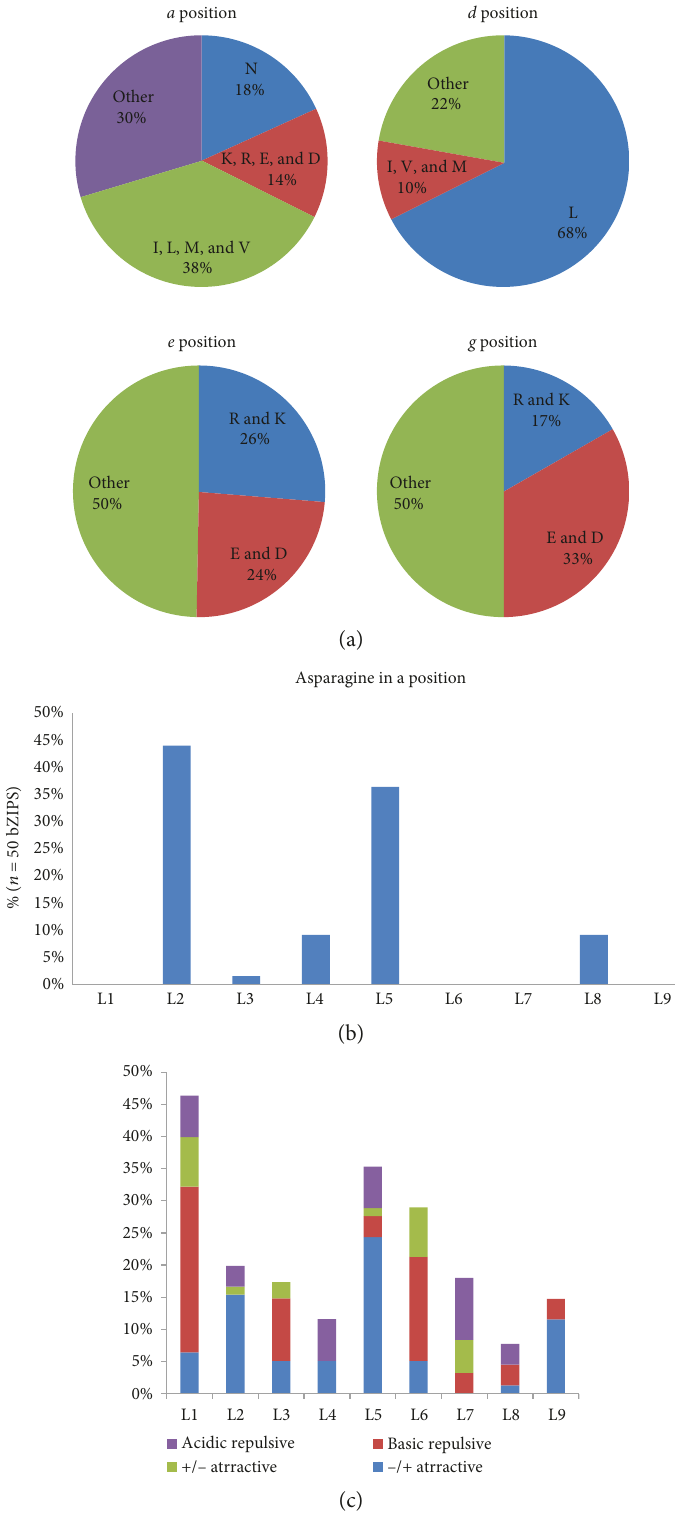
Figure 4: Prediction of the dimerization properties of FvbZIP proteins. (a) Pie charts depicting the frequency of di ff erent amino acids at the a , d , e , and g positions of the leucine zippers of all FvbZIP proteins (see Supplementary Figure S 3 for the amino acid positions within the leucine zipper regions). (b) Histogram of the frequency of the Asn residues present at the a position of each heptad within leucine zipper for all bZIP proteins. (c) Histogram of the frequency of attractive or repulsive g ↔ e ′ pairs per heptad within leucine zipper for all FvbZIP